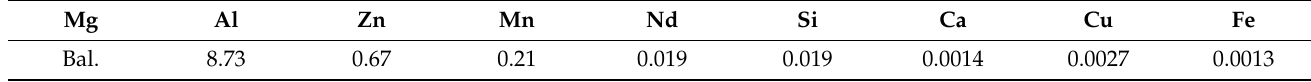
Table 1. Chemical composition of AZ91 alloy (wt